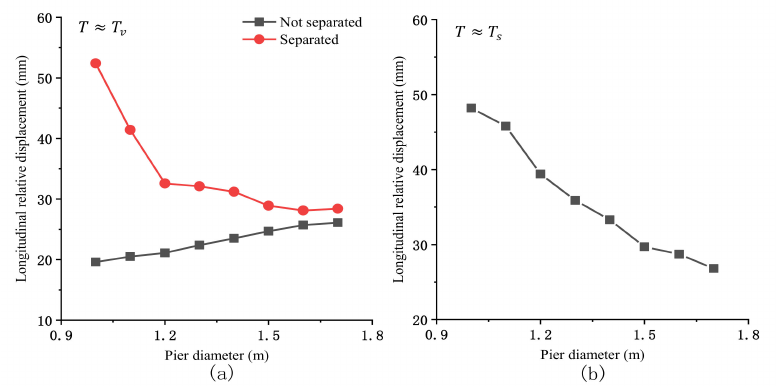
Figure 12. Longitudinal displacement of the pier and main girder with different pier diameters: ( a ) maximum relative longitudinal displacement of girder and pier when T ≈ T s ; ( b ) maximum relative longitudinal displacement of girder and pier when T ≈ T v .